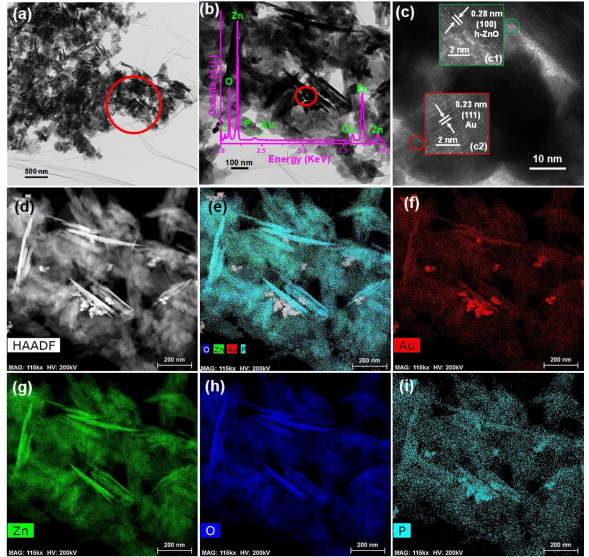
Figure 2. Characterization of the AZB sample. ( a ) TEM image of the AZB sample. ( b ) Enlarged TEM image of the marked region in the panel of ( a ). Inset displays the energy-dispersive X-ray spectrum of the AZB sample. ( c ) HRTEM image of the marked region in the panel of ( b ). Insets (c1) and (c2) display the HRTEM images of ZO and Au NPs, respectively. ( d ) High-angle annular dark-field (HAADF) image of the AZB sample and elemental maps of ( e ) the AZB composite, ( f ) Au, ( g ) Zn, ( h ) oxygen (O), and ( i ) phosphorus